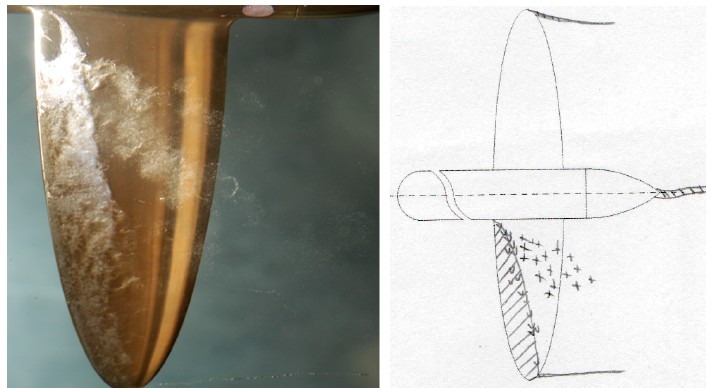
Figure 8. Cavitation extent observed in the experiments with U ∞ = 8 m/s and σ = 1.27. Left picture shows a photograph of the right foil of the cavitator in the experiments, and right picture shows a sketch of the mean cavitation extent on the cavitator. The pictures are reproduced with permission from Rhena Klose